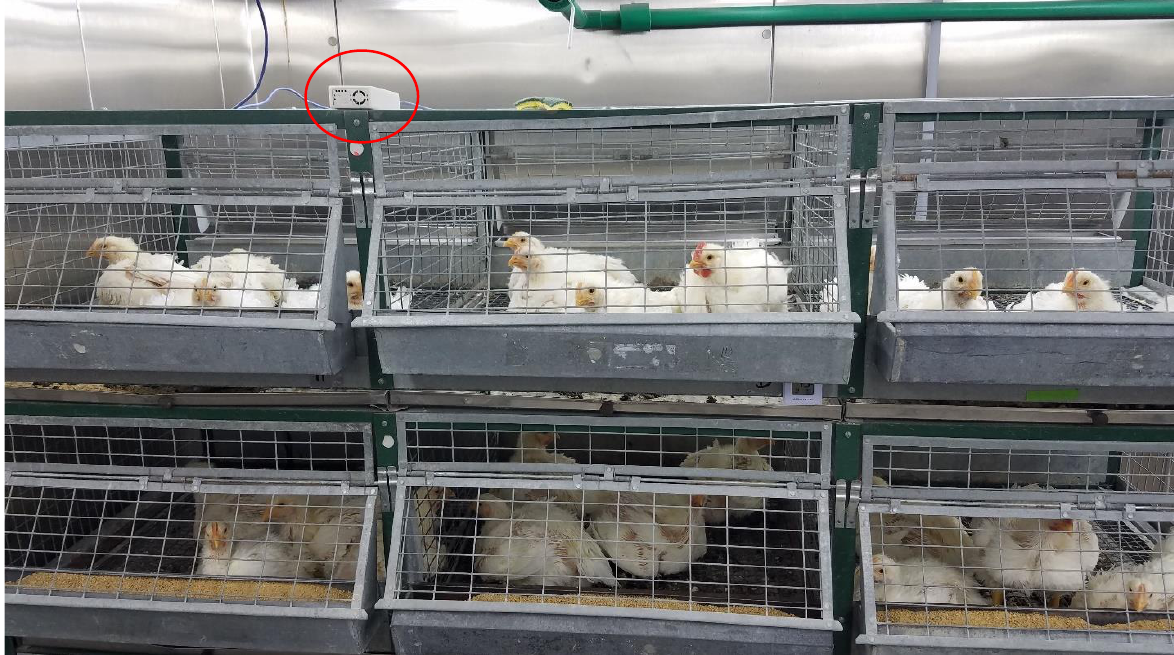
Figure 13. PMS5003 dust sensor enclosure (circled in red) placed on top of laying hen cages.